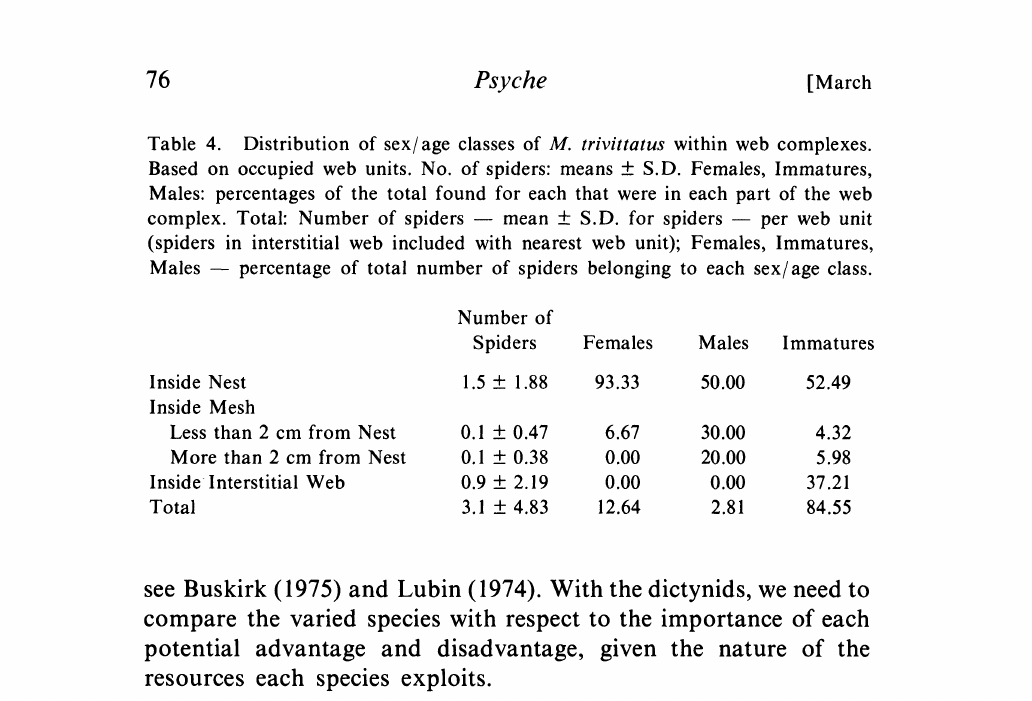
Inside Nest Inside Mesh Less than 2 cm from